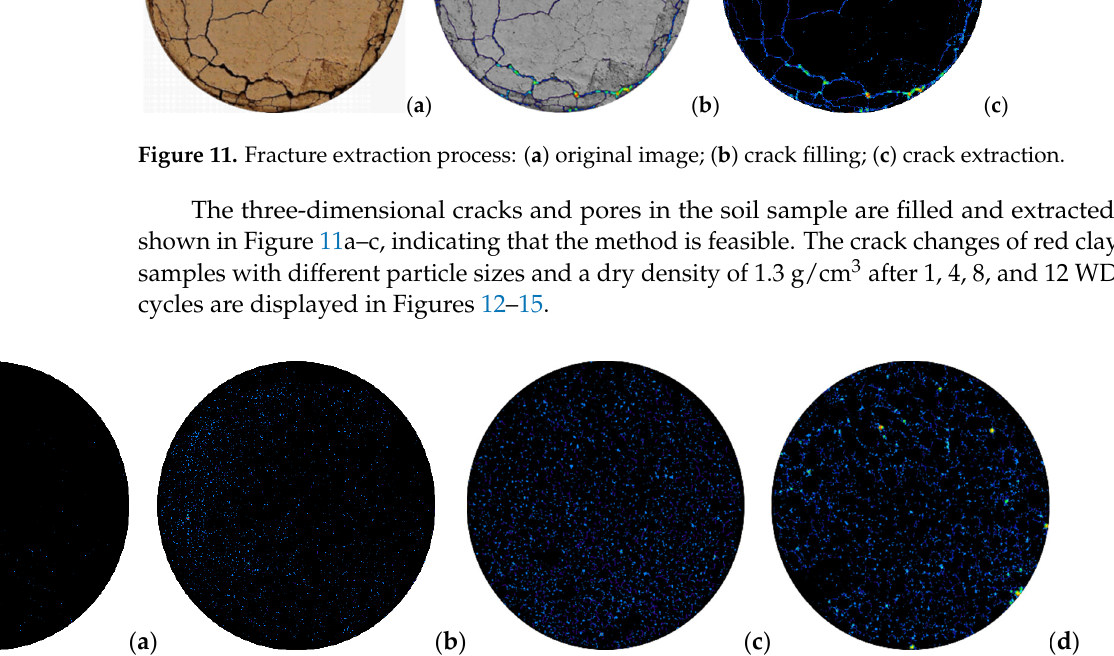
Figure 13. Cracks in soil sample after 4 WD cycles: ( a ) 0.25 mm; ( b ) 0.50 mm; ( c ) 2.00 mm; ( d ) 5.00 mm. Figure 14. Cracks in soil sample after 8 WD cycles: ( a ) 0.25 mm; ( b ) 0.50 mm; ( c ) 2.00 mm; ( d ) 5.00 mm. Figure 15. Cracks in soil sample after 12 WD cycles: ( a ) 0.25 mm; ( b ) 0.50 mm; ( c ) 2.00 mm; ( d ) 5.00 mm.